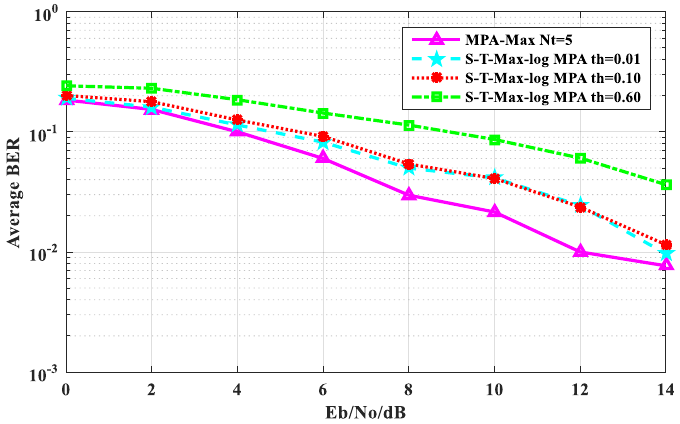
Figure 5. Comparison of the average BER performance when t max = 5.